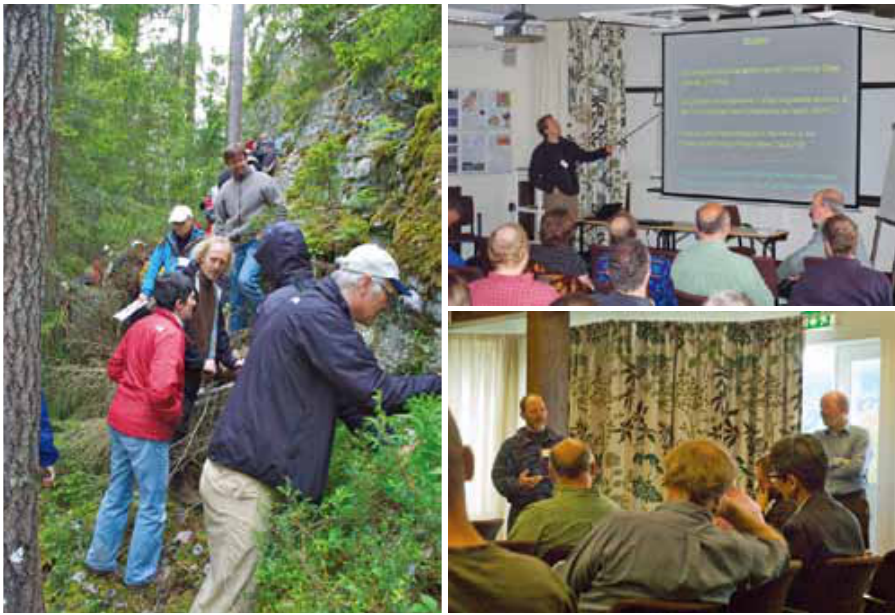
Figure 2. Scenes from the COSC science workshop presentations, discussions, and excursions. Participants on one of the key localities of the lower, poorly exposed tectonostratigraphic